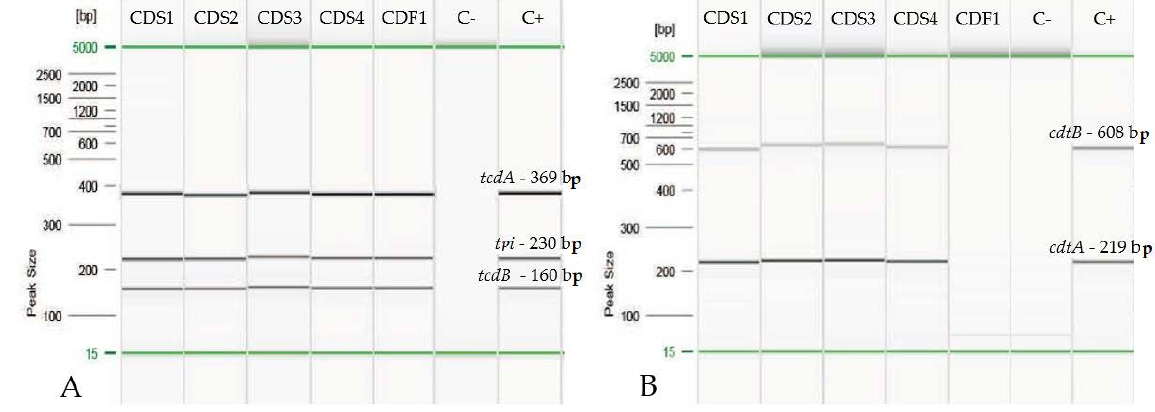
Figure 1. Capillary electrophoresis results (QIAxcelScreengel 1.4.0 software). Multiplex PCR for detection of tpi , tcdA and tcdB ( A ). Multiplex PCR for detection of cdtA and cdtB ( B ). Table 3. Ribotype, toxinotype and MICs values (mg/L) of C. difficile isolates. Isolate